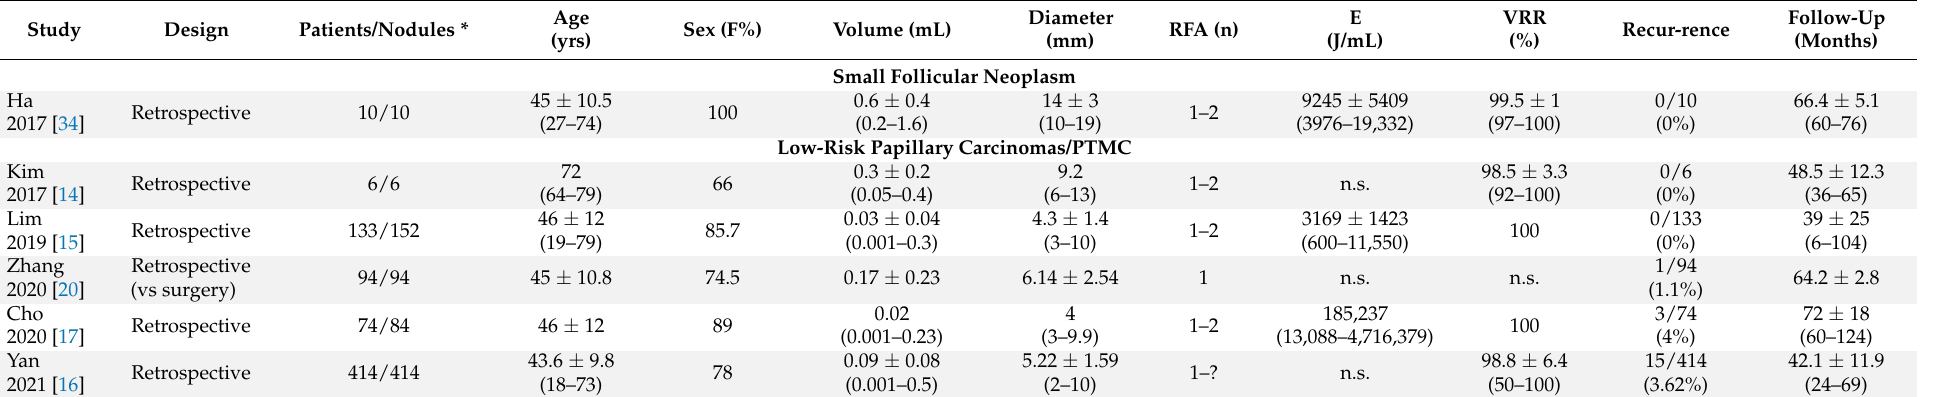
Table 5. Studies on RFA long-term outcomes in patients with low-risk thyroid